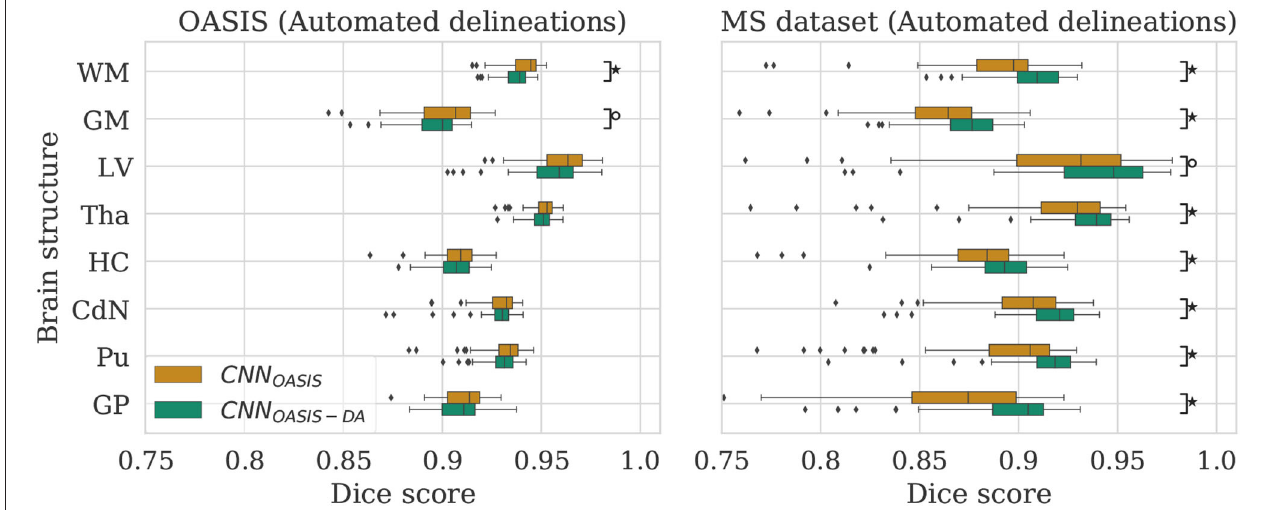
FIGURE 3 | Dice scores for the CNN OASIS and CNN OASIS - DA models on the OASIS (left) and MS dataset (right) test sets. Marks indicate that there is a significant difference between the two models (Wilcoxon, ◦ p < 0.05, ⋆ p < 5 × 10 − 4 ).